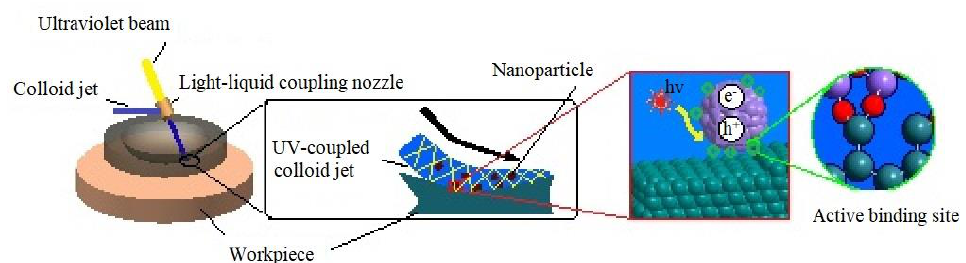
Figure 1. Schematic diagram of ultraviolet induced nanoparticle colloid jet machining.